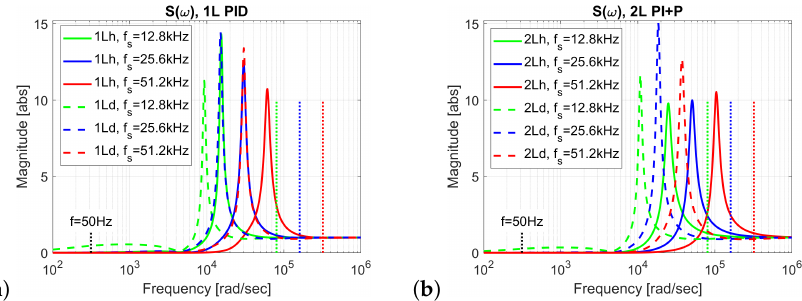
Figure 27. S ( ω ) and comparison of ( a ) 1L structures and ( b ) 2L structures at various f s